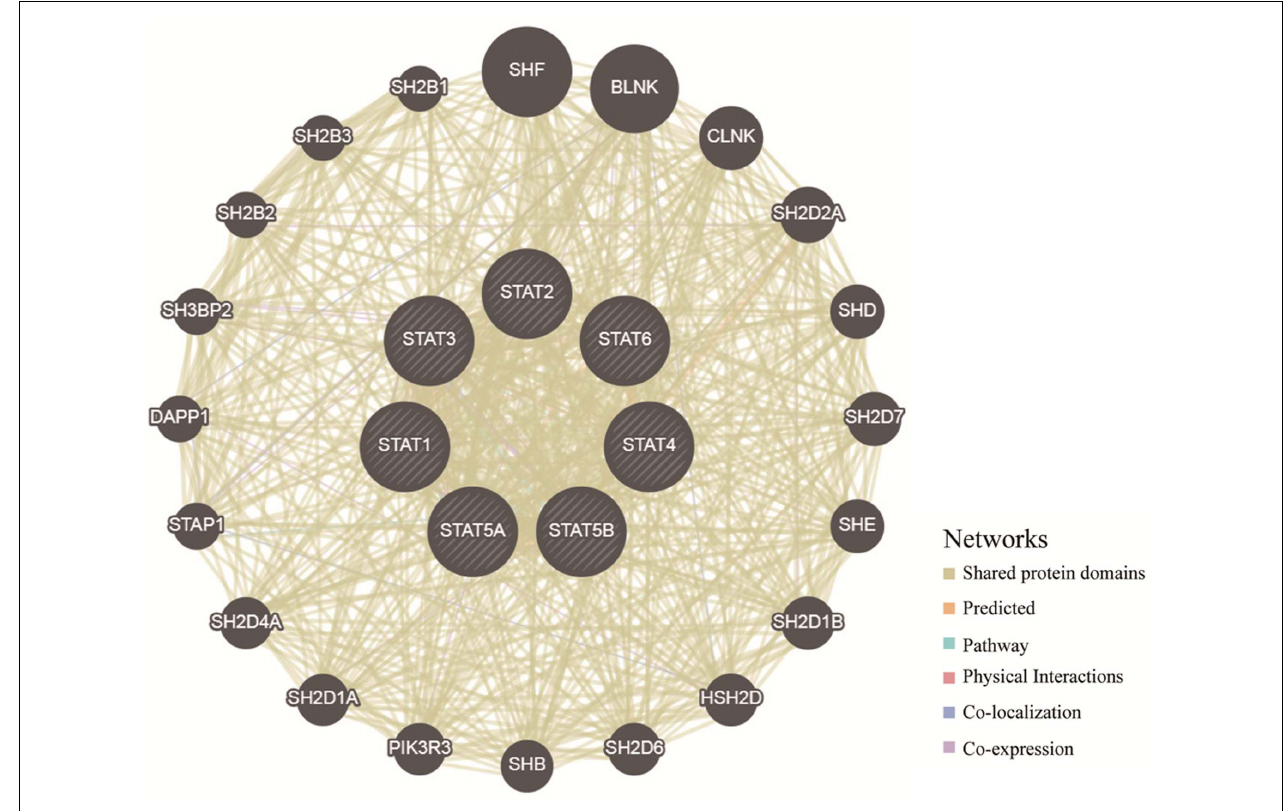
FIGURE 8 | Protein–protein interaction network of STAT family members (GeneMANIA). The colors of the lines between different genes represent the methods performed: Shared protein domains, Predicted, Pathway, Physical Interactions, Co-localization, and